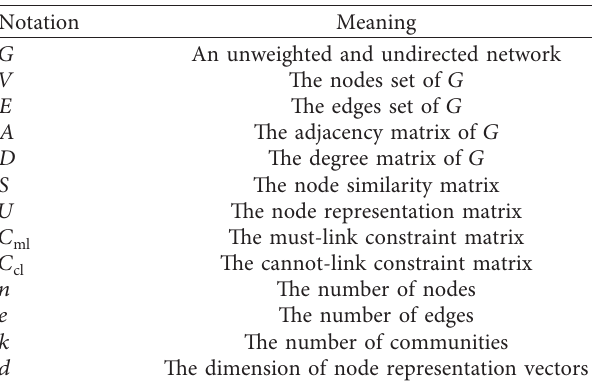
Table 1: The frequently used